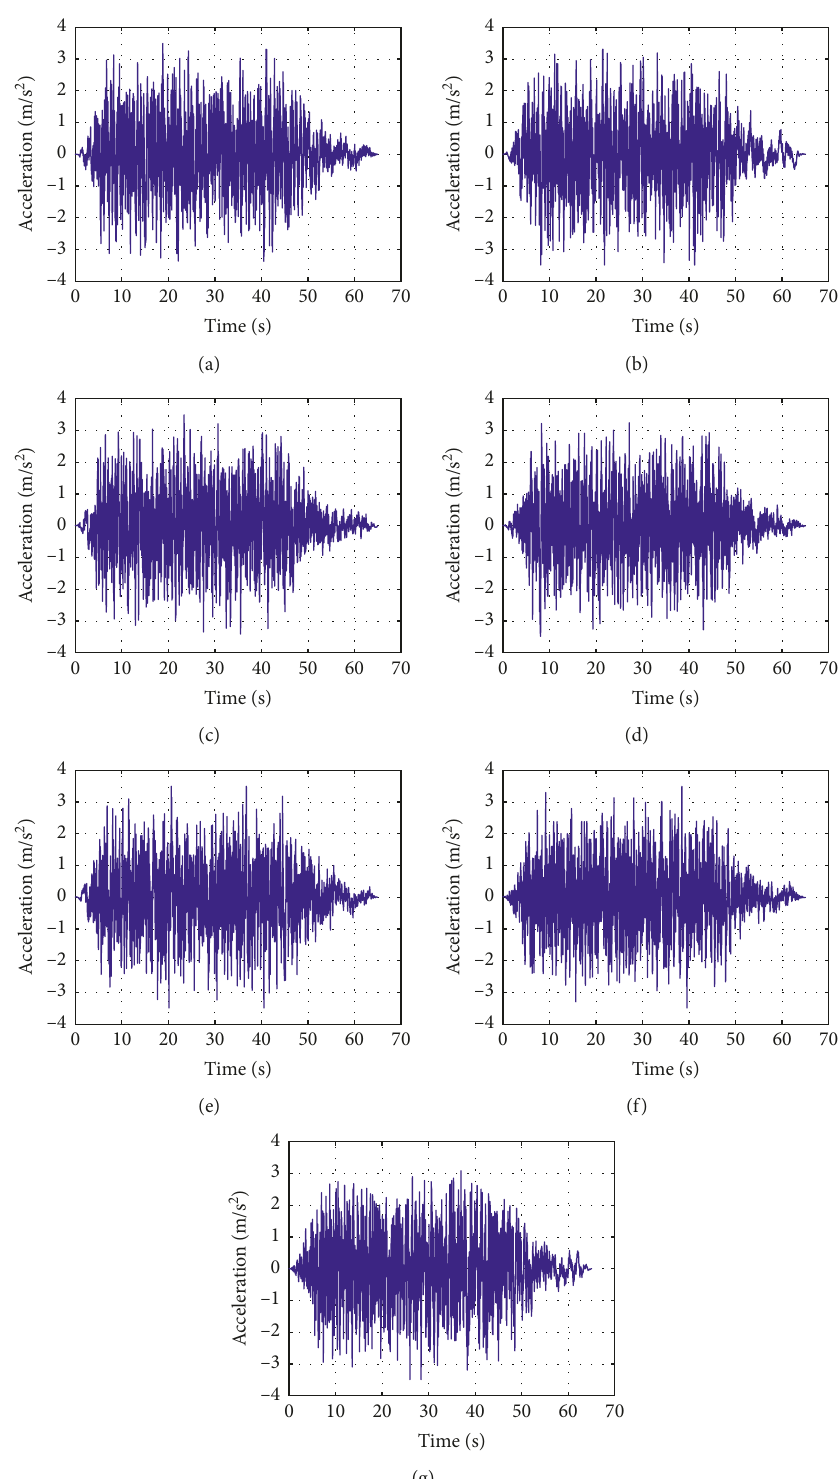
Figure 7: Samples of acceleration time